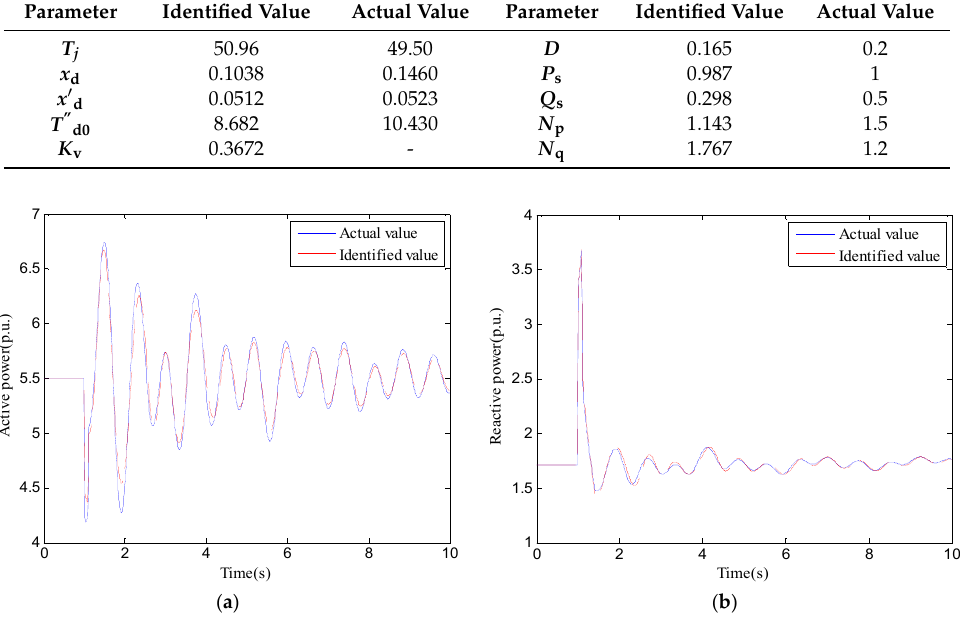
Table 1. Comparison of the identified parameters and the actual parameters of the model (p.u).